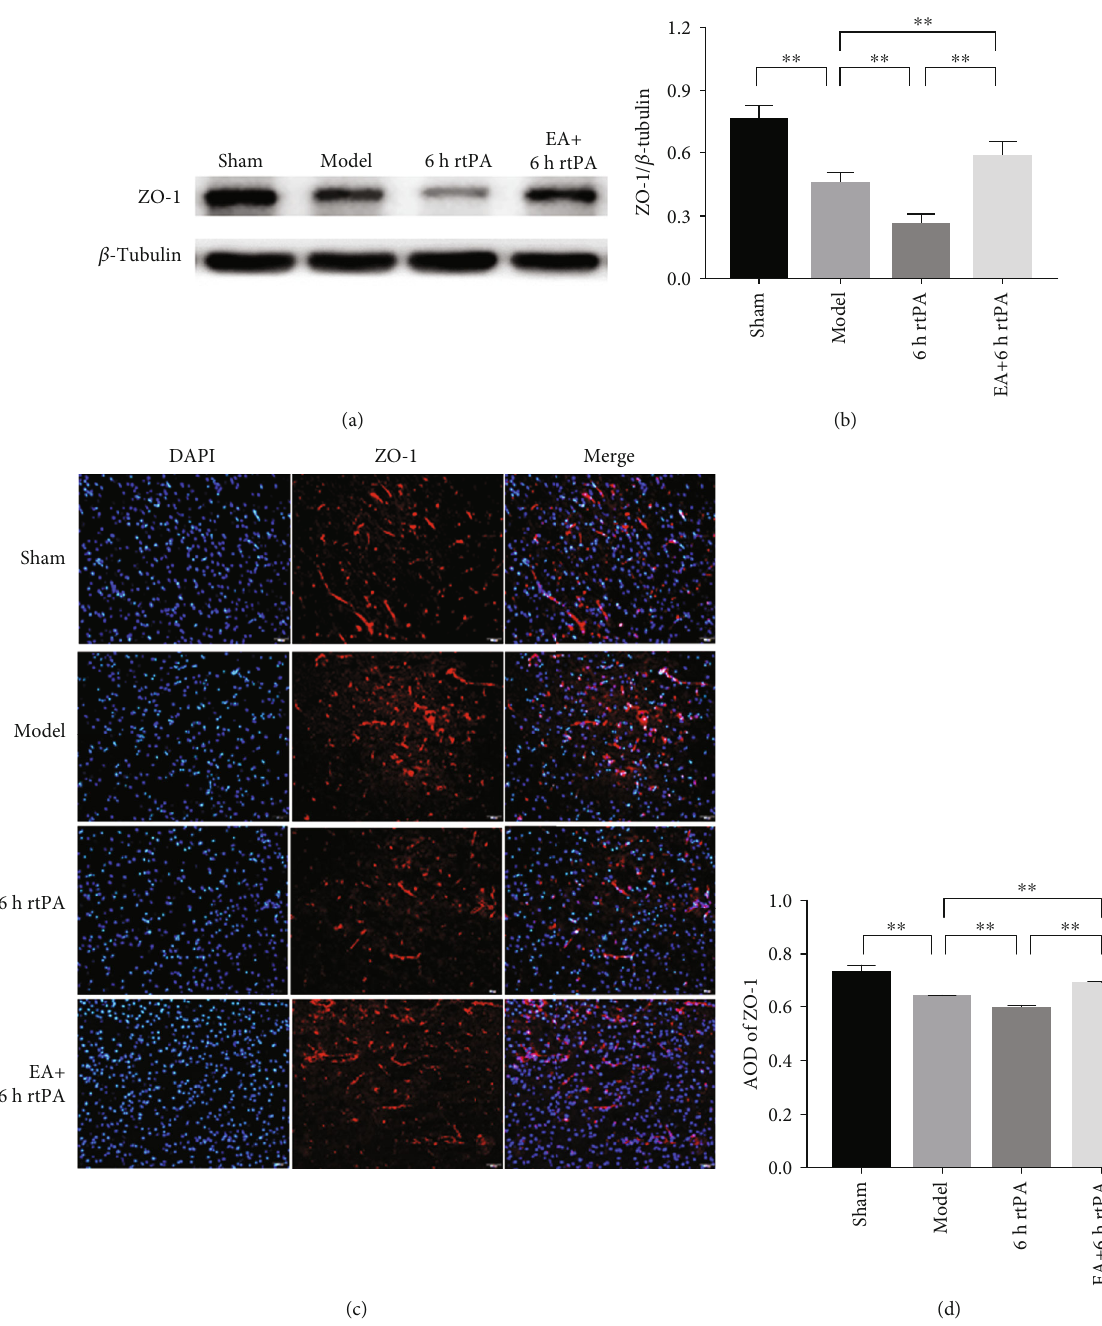
Figure 4: Western blot and immuno fl uorescence staining for ZO-1 in each group ( n = 6 rats). (a) Representative immunoblot showing the level of ZO-1 in the ischemic penumbra area. (b) Relative levels of the ZO-1 protein. (c) Representative images of ZO-1 staining in the ischemic penumbra area. Bar = 50 μ m . (d) Average optical density of ZO-1. ∗∗ indicates p < 0 : 01